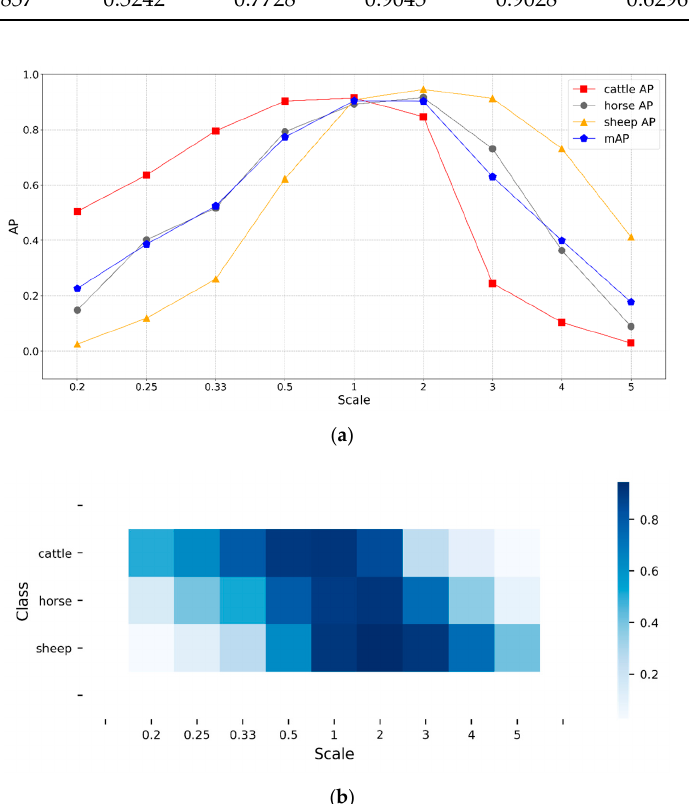
Figure 14. ( a ) The line graph of the 𝐴𝑃 values of ca tt le, horse, sheep, and 𝑚𝐴𝑃 on the multi-scale test dataset; ( b ) the heat map of the 𝐴𝑃 values of the three types of objects on the multi-scale test dataset. This more intuitively re fl ects the di ff erence in the detection of scale changes in the model for ca tt le, horses, and sheep.